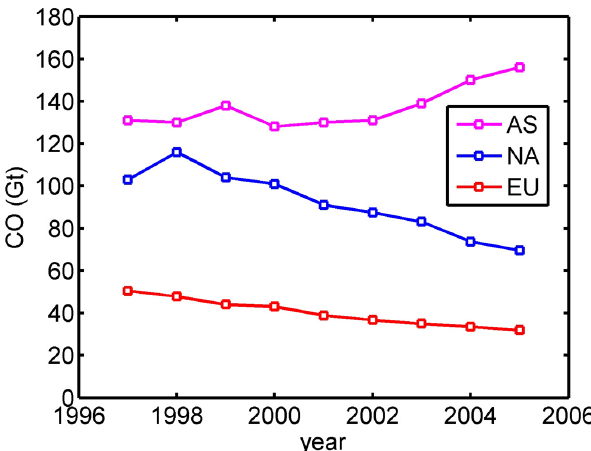
Fig. 13. CO emissions over time for AS (India+China), EU (OECD and Central Europe) and NA (USA+Mexico). Source: EC-JRC/PBL. EDGAR version 4.1. http://edgar.jrc.ec.europa.eu/,